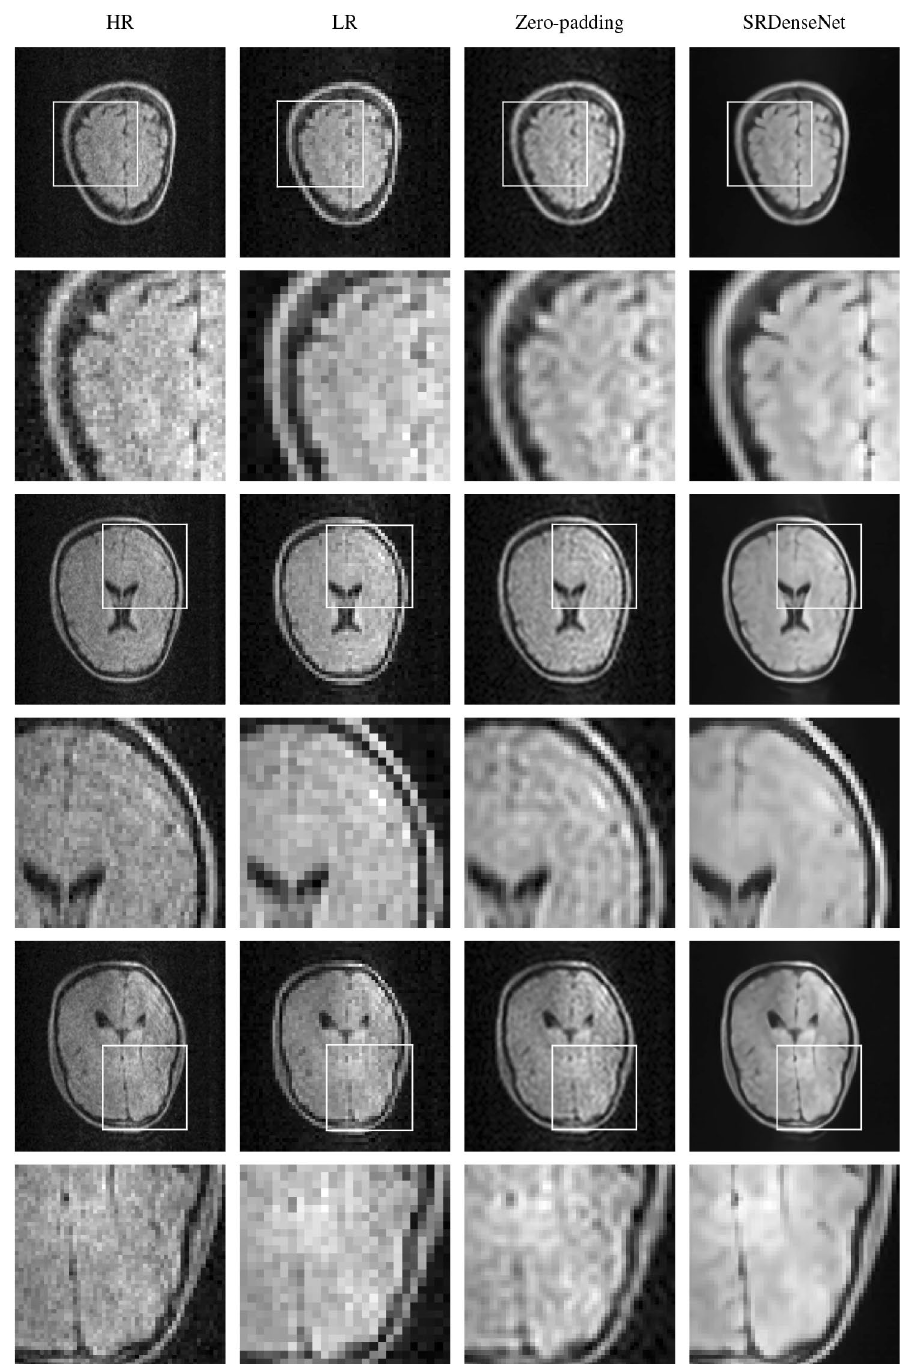
Figure 5. In the first column, we have three different HR slices of a brain image acquired using a low-field MRI scanner. These HR images are our reference images. The first, third and fifth rows show the full images, in the second, fourth and sixth rows we find zoomed-in versions of patches of the images in the first, third and fifth rows. The second column shows the LR images corresponding to the HR images in the first column. These images are fed into the trained convolutional neural network. The third column shows the SR images obtained by zero-padding k-space, and in the fourth column, we see SR images obtained by applying